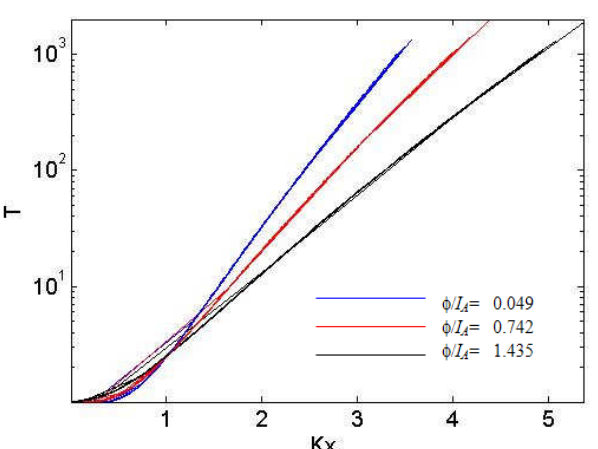
Fig. 6. Maximum skewness coefficient vs. r H /r 2 ε =0.3 (magenta) and 3 p =21, ε =0.4